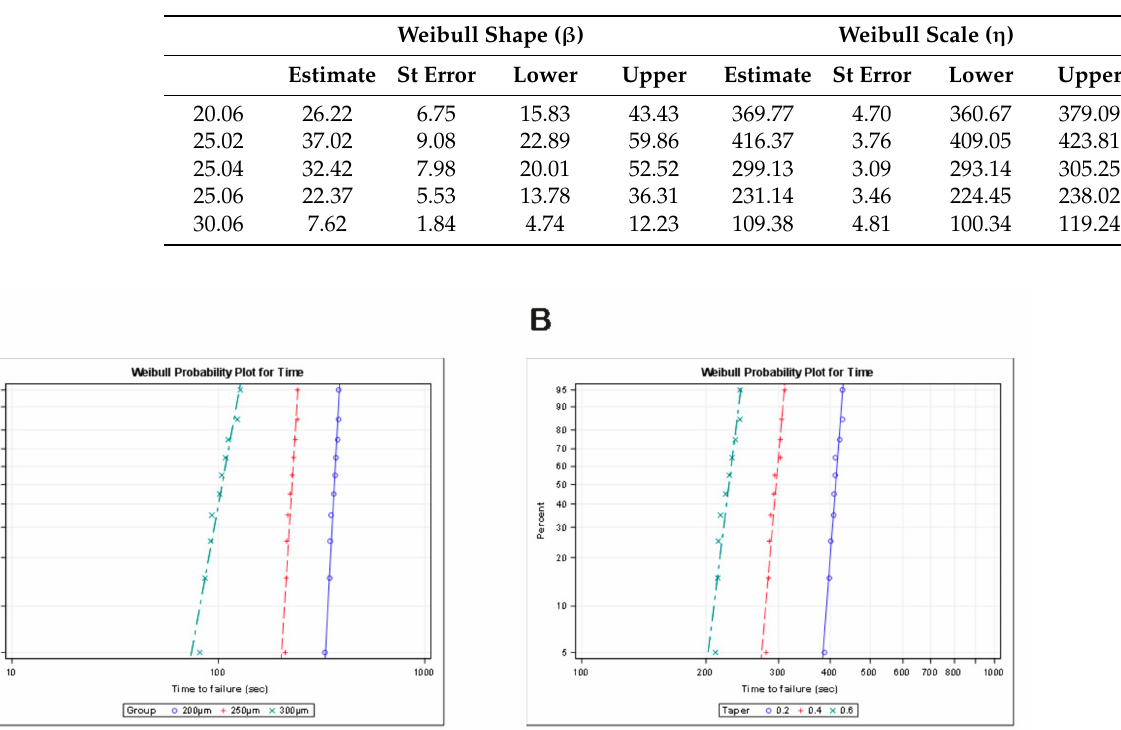
parameter ( β ) of the Weibull statistics showed statistically significant differences between the time to failure of the 20.06 and 25.06 apical diameter study groups ( p < 0.001) and 20.06 and 30.06 apical diameter study groups ( p = 0.002); however, it did not show statistically significant differences between the time to failure of the 25.06 and 30.06 apical diameter study groups ( p = 0.656) (Table 2, Figure 6A). Table 2. The Weibull statistics of the time to failure for the apical diameter and taper study groups.